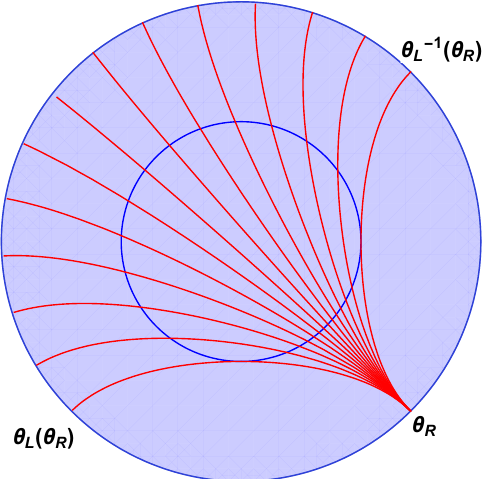
Figure 4 . In eq. (2.10), setting the upper limit of integration to the locus (cid:18) L = (cid:18) L ( (cid:18) R ) and the lower limit to (cid:18) L = (cid:18) (cid:0) 1 ( (cid:18) R ) results in an integration region, which encompasses all oriented L geodesics that intersect the bulk curve. Here we display which geodesics are integrated over for a (cid:12)xed value of (cid:18) R